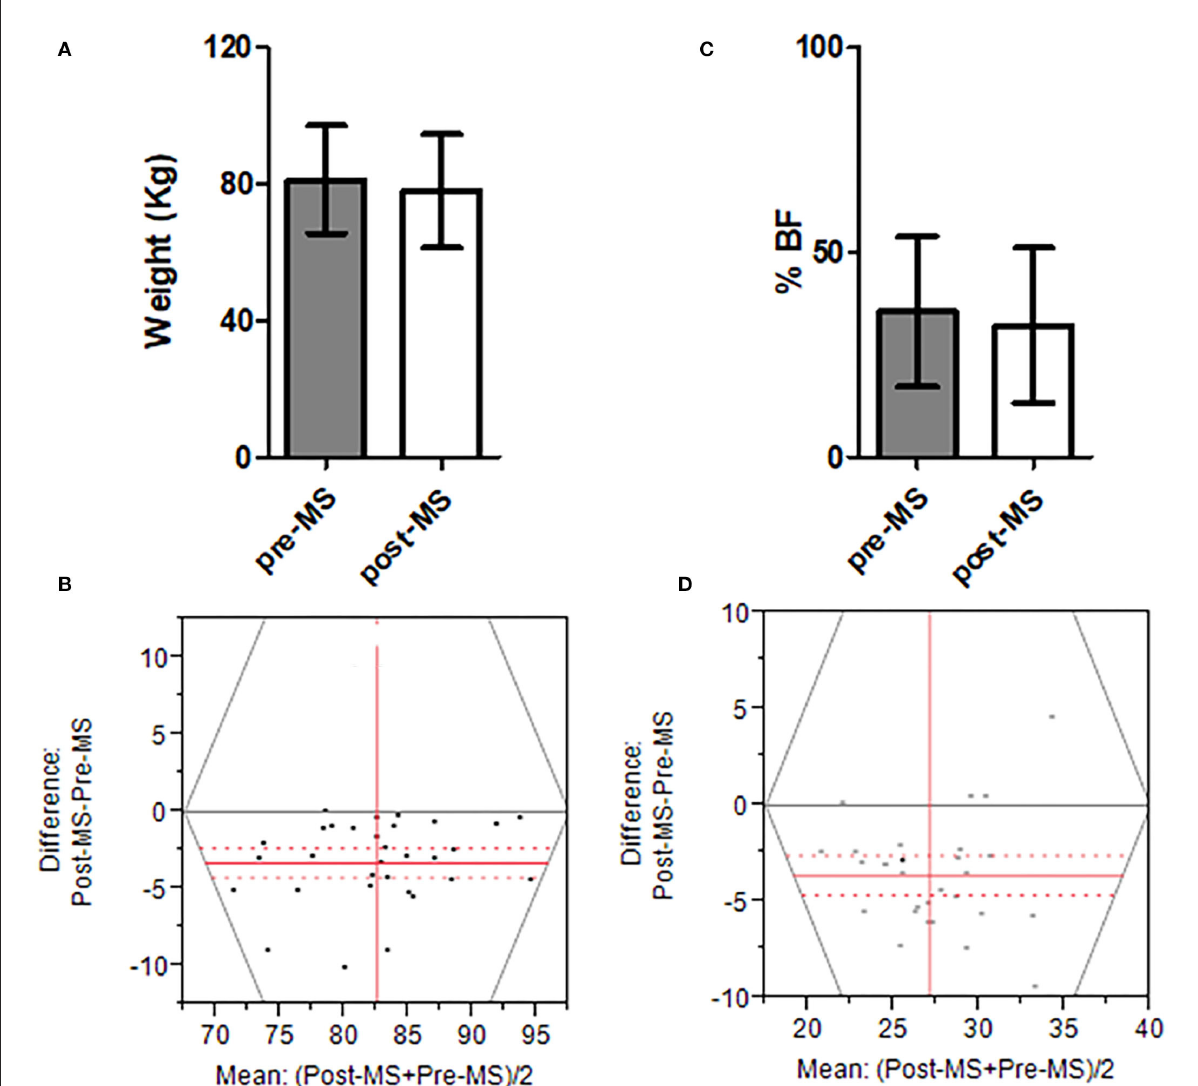
FIGURE2 Mean body weight Pre- and Post-MS Salat regimens. (A) The mean body weight of Pre-MS and Post-MS regimens. (B) The difference in body weight between Pre-MS and Post-MS regimens. (C) %BF of Pre-MS and Post-MS regimens. (D) The difference in %BF between Pre-MS and Post-MS regimens. In (B,D) , the gray solid line shows “zero difference”. The red solid line is the mean difference. The dashed red lines are 95% confidence bands. The P -value for all analyses was < 0.05. All analyses were performed using “matched paired